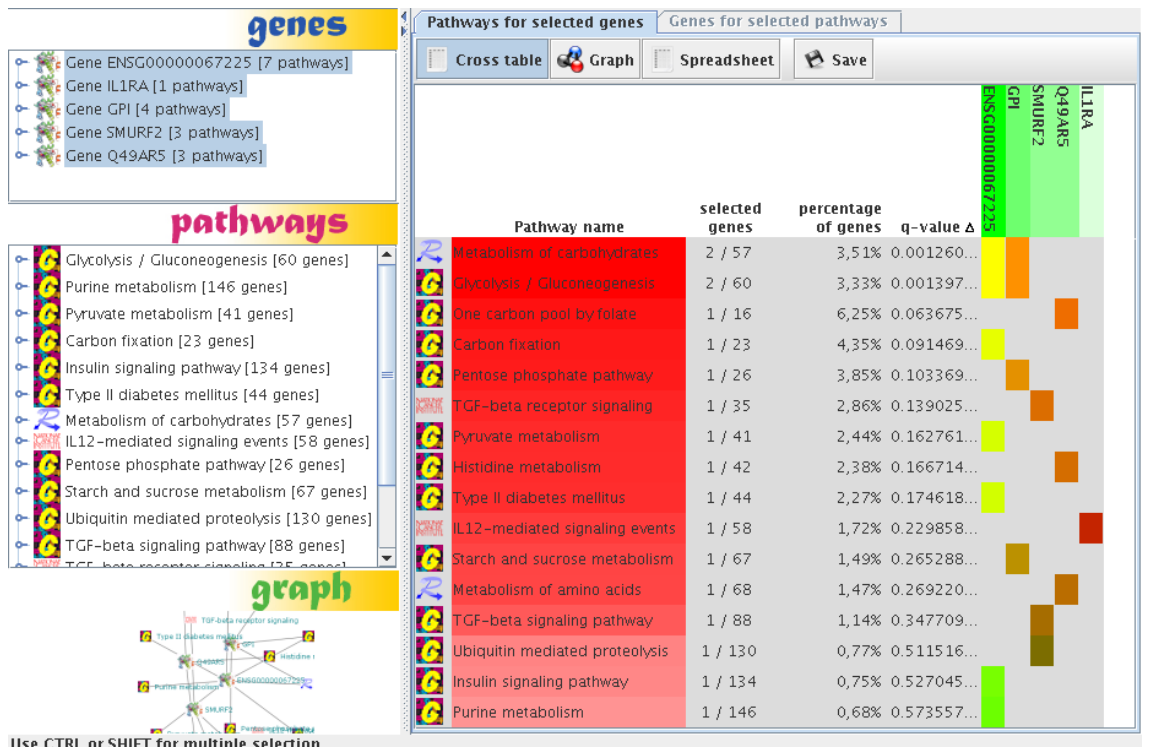
Figure 2: PathJam screenshot showing the results obtained from a simple list of genes. A two- tailed fisher’s exact test gives information about enriched biological pathways with adjusted p- values using multiple testing correlation. Columns can be ordered by any